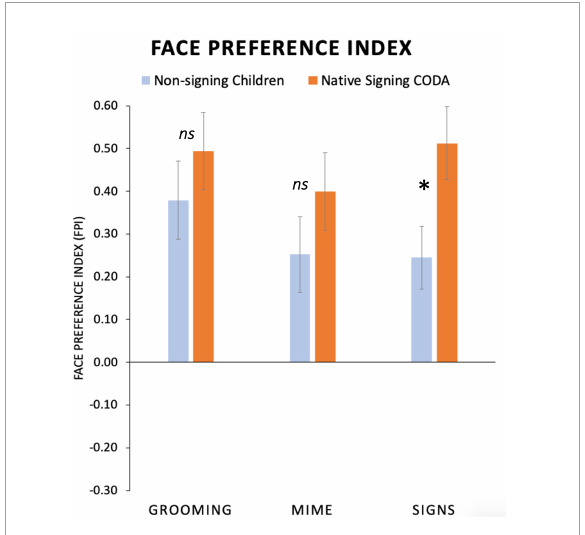
FIGURE6 Average face preference index (FPI) values for non-signing and signing young children at the mean age of 5 years. Positive FPI values indicate greater attention devoted to the face than the torso area and negative values indicate the opposite preference. All participants had a high positive FPI. No group differences were seen for Grooming or Mime actions. For Signs, native signing children had a significantly greater FPI than the non-signing children. (Standard error bars plotted ∗ , p < 0.05). ns, not